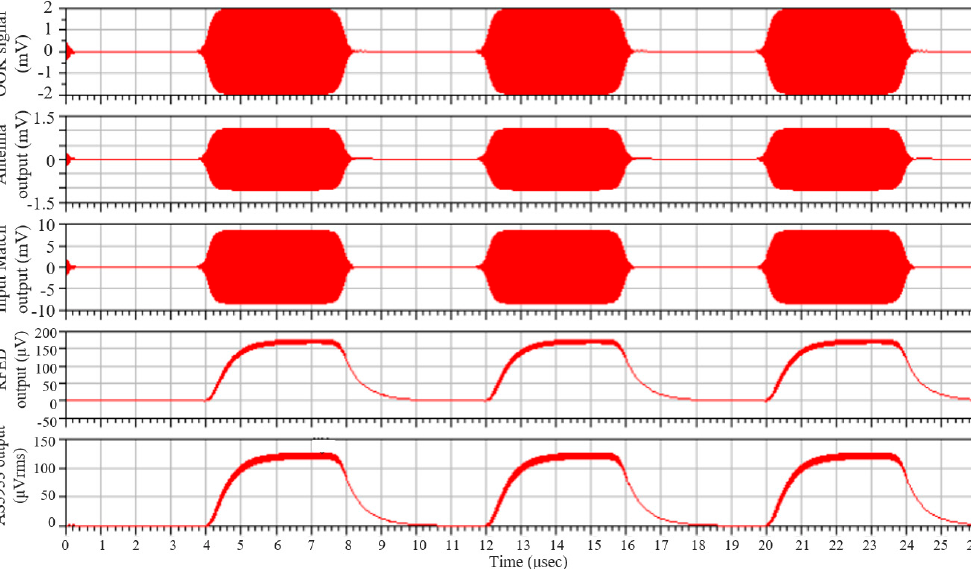
Figure 3. Results of the determination of the overall WuR sensitivity. A 2 mV peak On/Off keying (OOK) signal is generated and passed through the antenna model and the radiofrequency envelope detection (RFED), finally reaching the AS3933 model. The plotted waves represent, from top to bottom, the generated OOK signal and the outputs obtained after the antenna, the input matching network, the RFED and the AS3933.